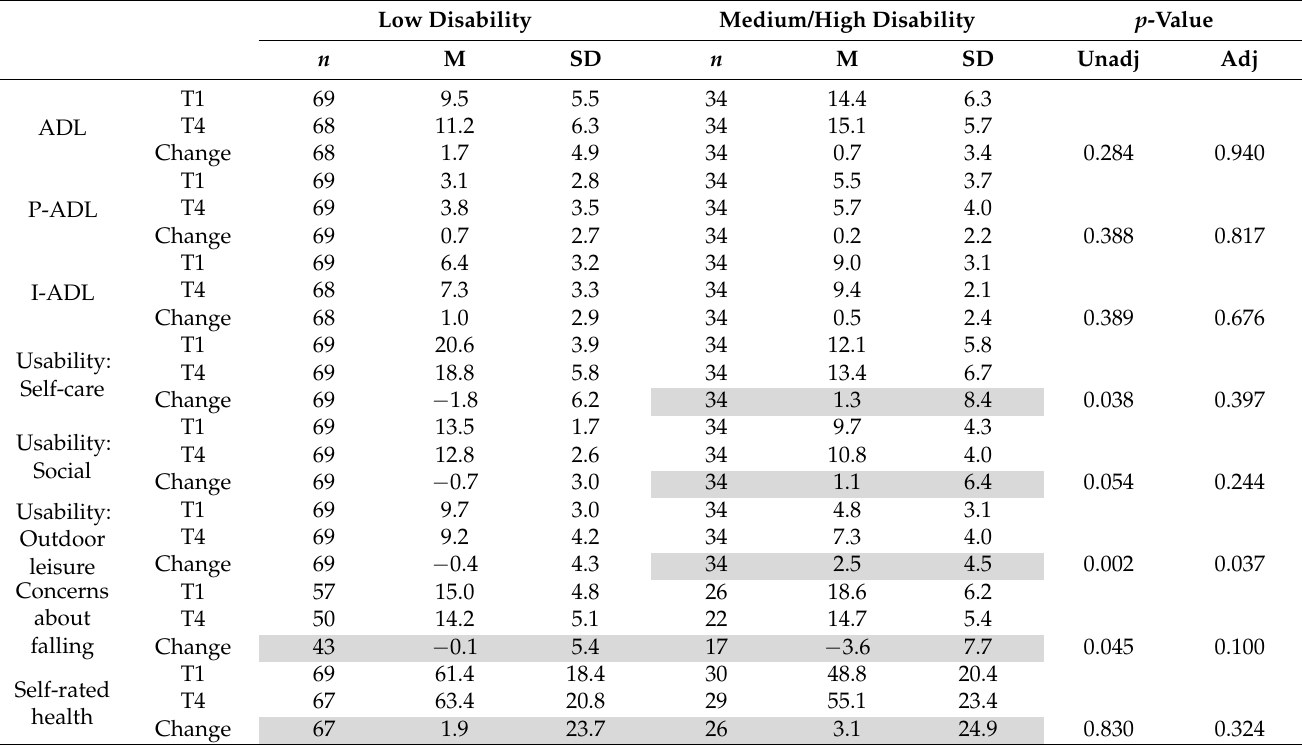
Table 4. Values at T1 and T4, and one-year-changes for the aggregated client profiles with p -values for comparisons estimated using analysis of variance (ANOVA). Favorable outcomes (i.e., less dependence in ADL, increased usability and self-rated health, and less concerns about falling) are marked with grey